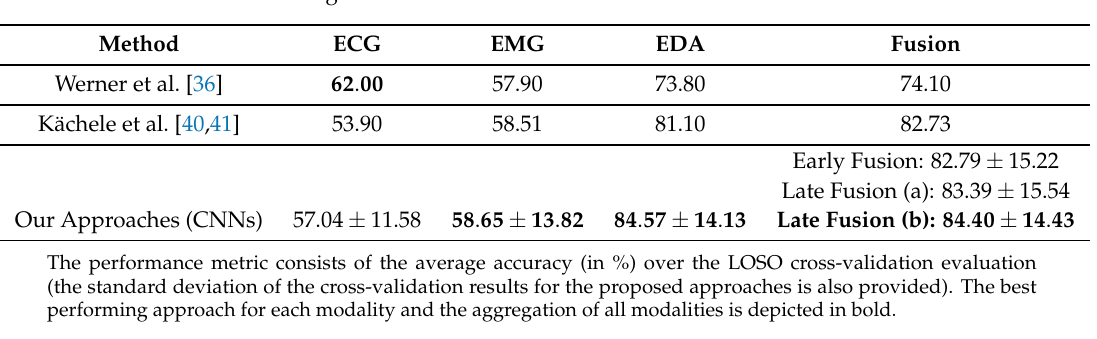
Table 3. Performance comparison to early work on the BVDB (Part A) for the classification task T 0 vs. T 4 in a LOSO cross-validation